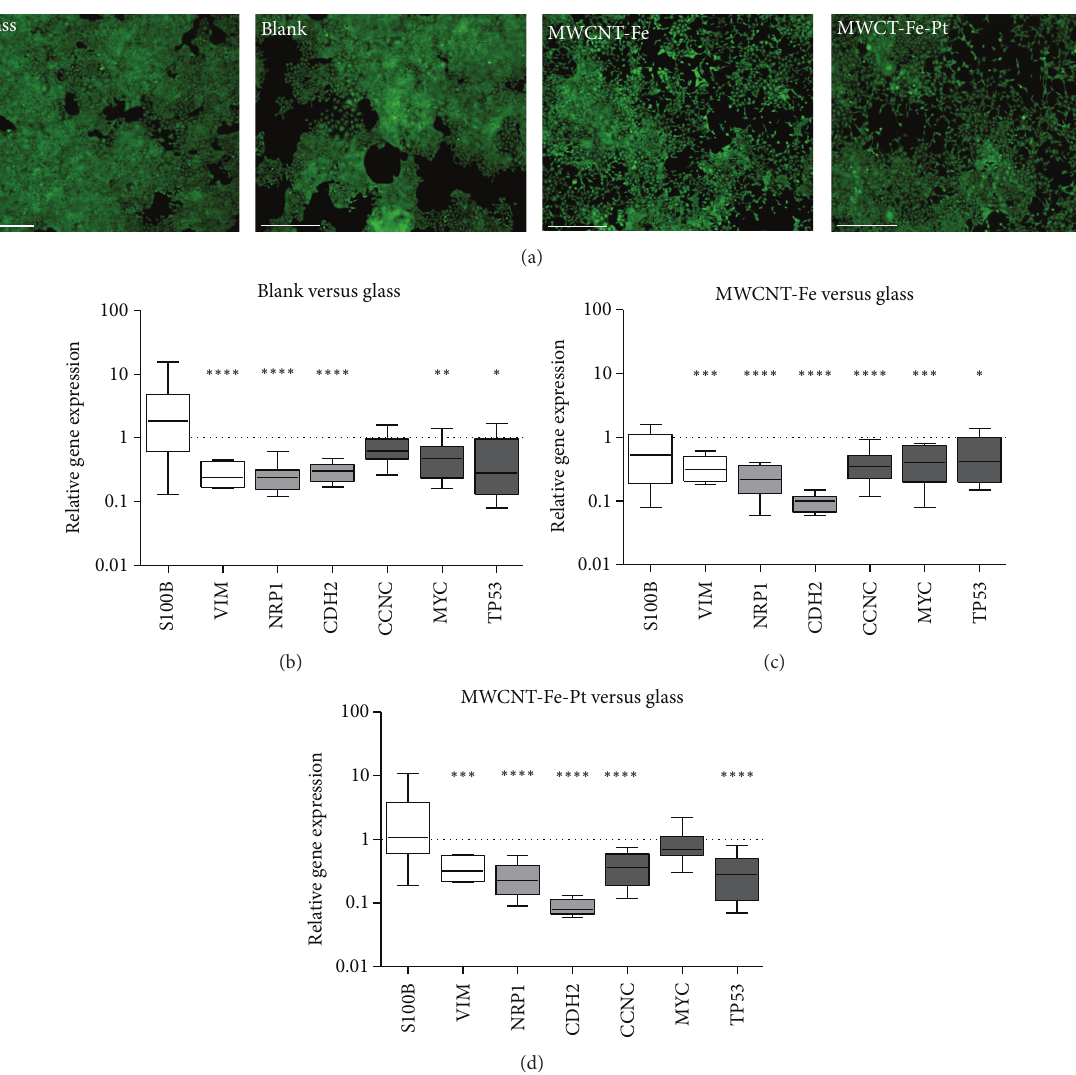
Figure 5: Evaluation of relative gene expression patterns in R28 cells. Cells were plated on a glass substrate and on the blank, MWCNT-Fe, and MWCNT-Fe-Pt wafer slices ( 𝑛 = 2 individual experiments). Cultivation was terminated 72 hours after seeding. (a) Fluorescence micrographs showed that R28 cells grown on the MWCNT-Fe and the MWCNT-Fe-Pt wafer slices did not exhibit the characteristic cluster formation as seen on the glass and the blank substrata but showed a lot of separated cells (scale bar: 500 𝜇 m). ((b)–(d)) qRT-PCR was performed to analyze the expression of different genes representing neuronal/glial and retinal markers or involved in the cell cycle. Using the comparative CT ( 2 −ΔΔ CT ) method, the relative gene expression ratio of cells cultivated on glass was set to 1. Regarding cultivation on the different wafer slices, values > 1 denote upregulation and values < 1 denote downregulation of gene expression. Each column represents the median, maximum, minimum, and the 50th percentile of the data. Data were analyzed using one sample two-tailed 𝑡 test. (b) ∗∗∗∗ 𝑃 < 0.0001 , VIM , NRP1 , and CDH2 ; ∗∗ 𝑃 = 0.0072 , MYC ; ∗ 𝑃 = 0.0472 , TP53 . (c) ∗∗∗ 𝑃 = 0.0002 , VIM ; ∗∗∗∗ 𝑃 < 0.0001 , NRP1 , CDH2 , and CCNC ; ∗∗∗ 𝑃 = 0.0003 , MYC ; ∗ 𝑃 = 0.0278 , TP53 . (d) ∗∗∗ 𝑃 = 0.0002 , VIM ; ∗∗∗∗ 𝑃 < 0.0001 , NRP1 , CDH2 , CCNC , and TP53